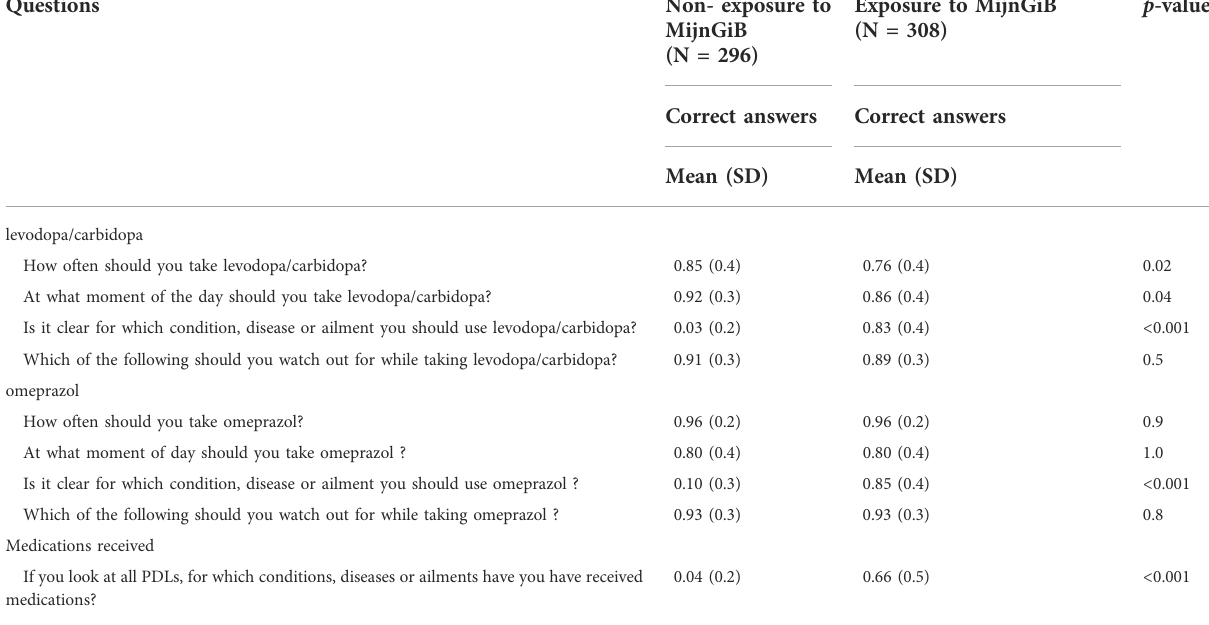
Table 2 For background characteristics of the